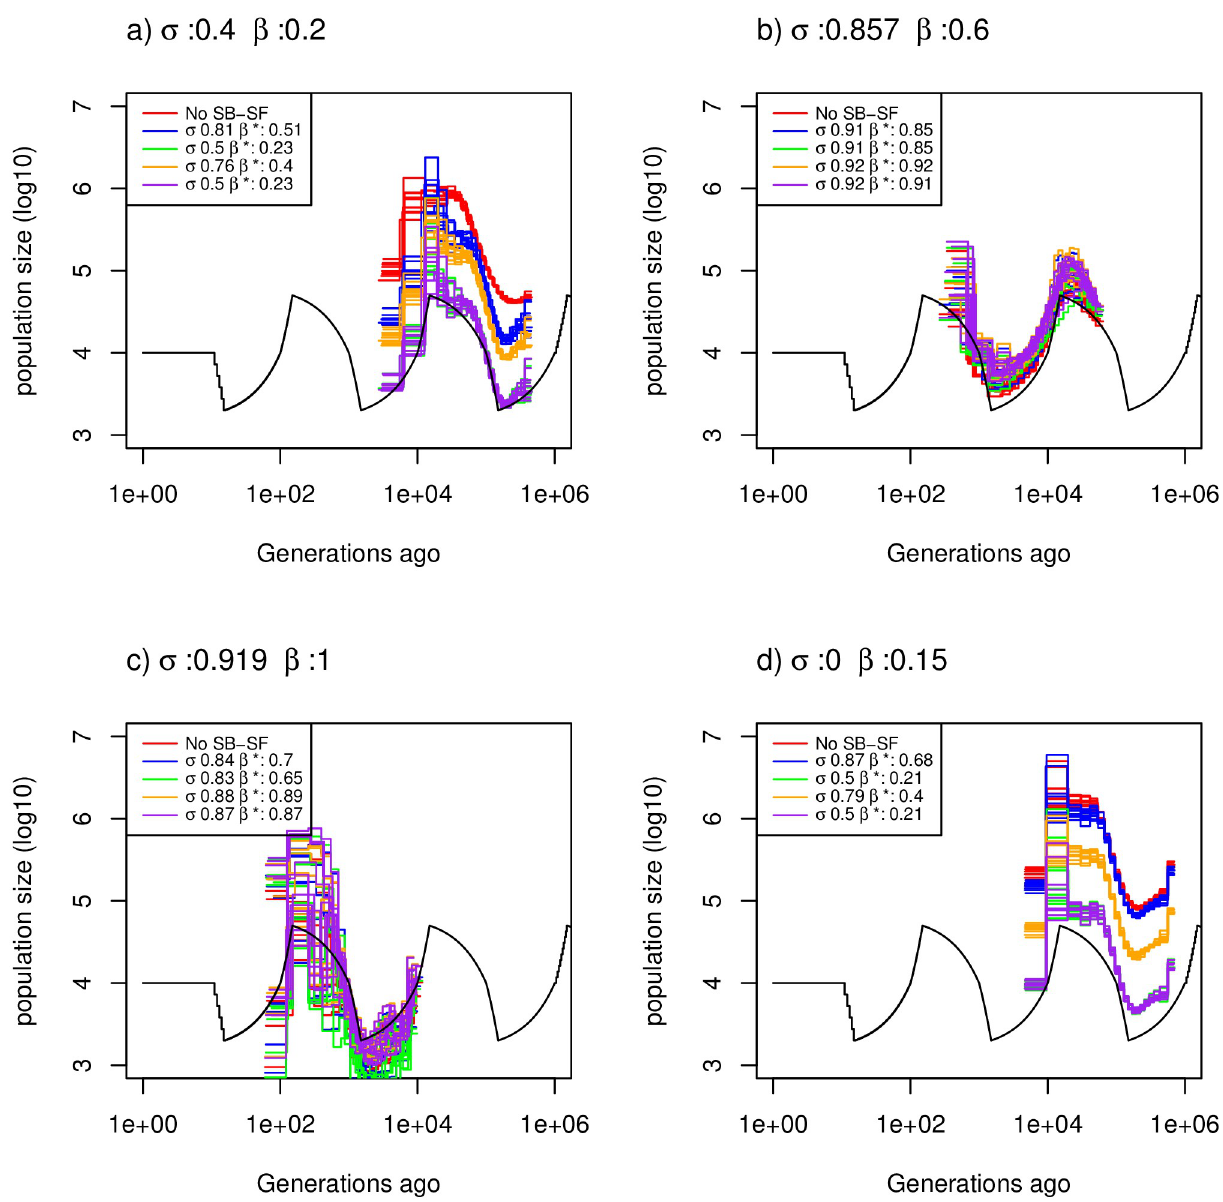
Fig 4. Estimated demographic history with selfing and seed banking. Demographic history estimated by eSMC for ten replicates using four simulated sequences of 10 Mb under a saw-tooth demographic scenario and four different combinations of germination ( β ) and self-fertilization ( σ ) rates but resulting in the same r . Mutation and recombination rates are set to 1.25 × 10 − 8 per generation per bp, giving r y and β = 0.25, b) σ = 0.75 and β = 0.6, c) σ = 0.85 and β = 1 and d) σ = 0 and β = 0.15. Hence, for each scenario r eSMC was launched with five different prior settings: ignoring seed-banks and self-fertilization (red), accounting for seed-banks and self-fertilization but without setting priors (blue), accounting for seed-banks and self-fertilization with a prior set only for the self-fertilization rate (green), only for the germination rate (orange) or for both (purple). σ � and β � respectively represent the estimated self-fertilization and germination rate.